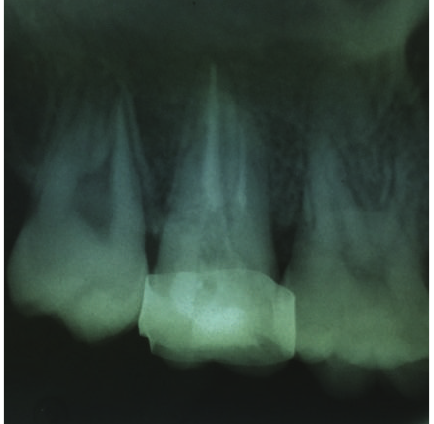
Figure 15: Radiograph showing internal reinforcement with Rib- bond in 27.